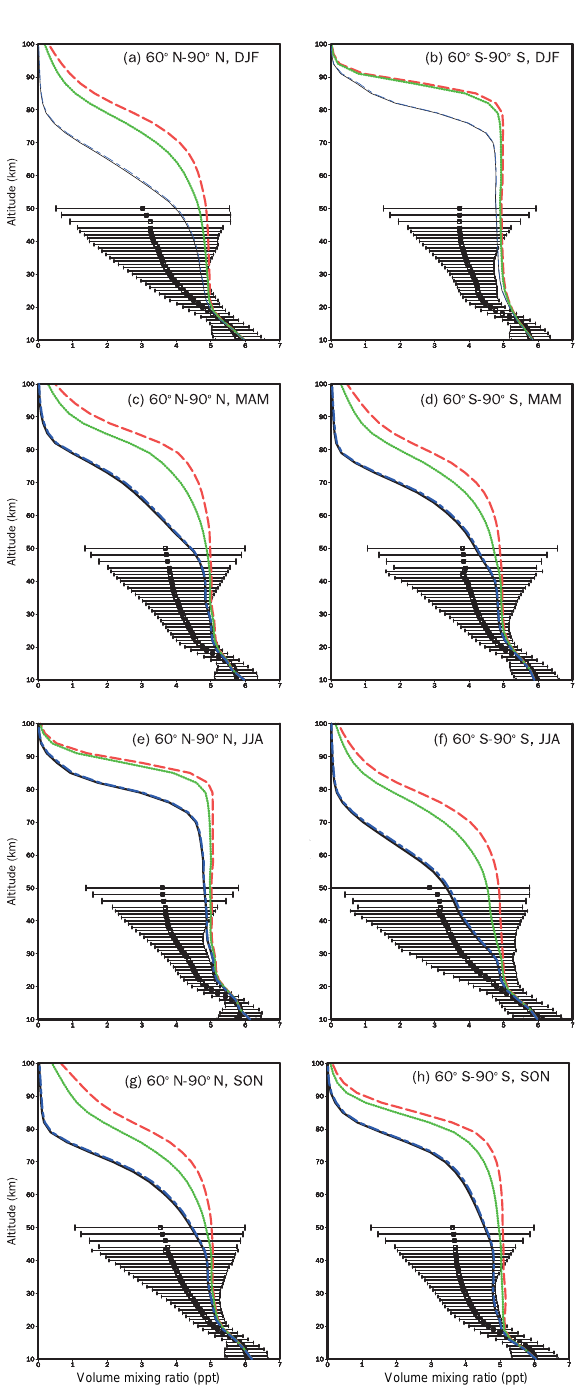
Figure 3. Seasonal mean volume mixing ratios (pptv) of the differ- ent SF 6 tracers for the polar regions (60–90 ◦ N and 60–90 ◦ S lati- tudes) in 2007 as a function of altitude for MIPAS (Michelson In- terferometer for Passive Atmospheric Sounding) satellite-observed SF 6 (black symbols with standard deviations for ± 1 σ ; Stiller et al., 2012), the total WACCM-SF 6 (blue solid line), the photolysis WACCM-SF 6 tracer (green solid line) and the inert WACCM SF 6 tracer (red dashed line).